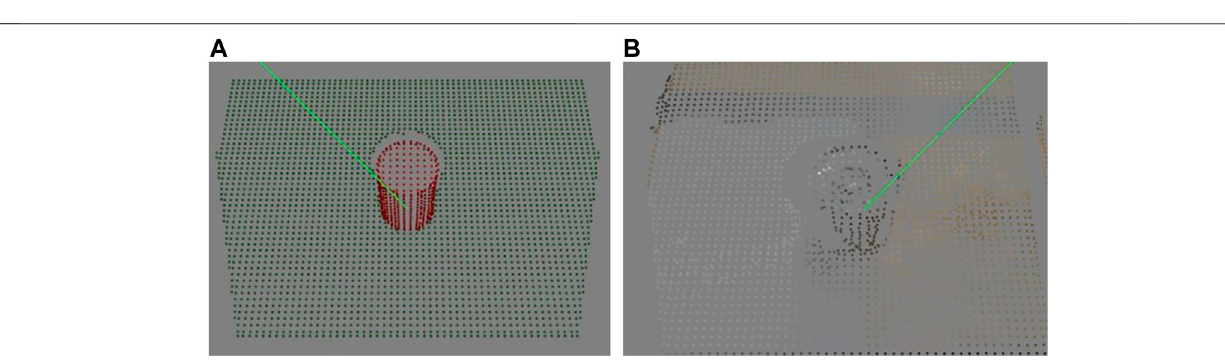
Frontiers in Robotics and AI |